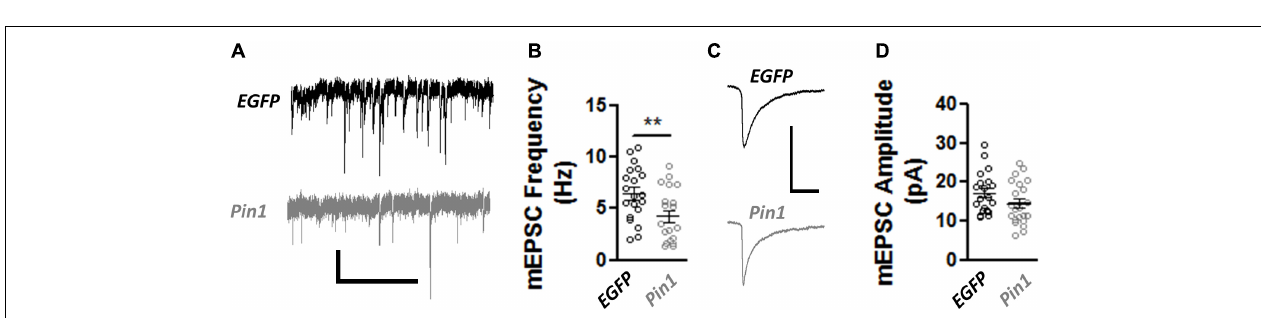
FIGURE 5 | Pin1 regulates excitatory synaptic transmission. (A) Electrophysiological mEPSCs voltage clamp recordings from hippocampal cultured neurons transfected with EGFP and Pin1. Scale bar 20 pA/2sec. (B) Pin1 decreases the frequency of mEPSCs. Normalized frequency of mEPSCs. EGFP 6.45 ± 0.59, n = 20; Pin1 4.23 ± 0.58, n = 20, unpaired t -test, ** p = 0.0109. (C) Average mEPSC traces. Scale bar 20 pA/20 ms. (D) Pin1 does not alter the amplitude of mEPSCs. EGFP 17.19 ± 1.19; Pin1 14.28 ± 1.27, n = 20, unpaired t -test, p = 0.11. Two dissociations, two recording sessions, and nine